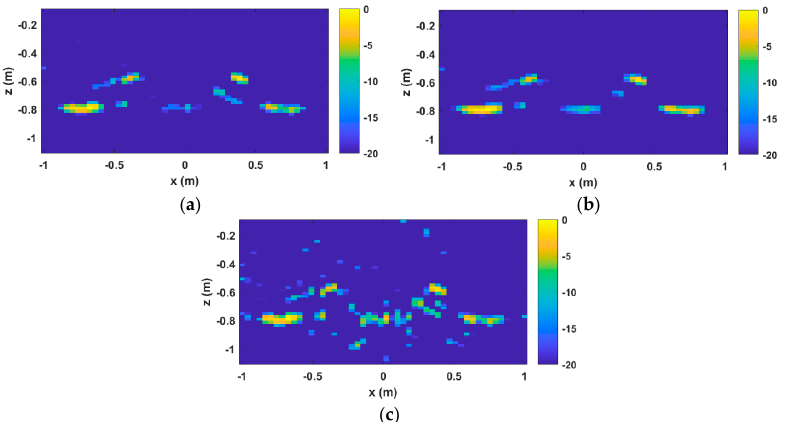
Figure 9. Reconstruction results for composite target scene using two transmitters and six receivers at an SNR of 0 dB. ( a ) GSR; ( b ) TVM; ( c ) standard l 1 -norm